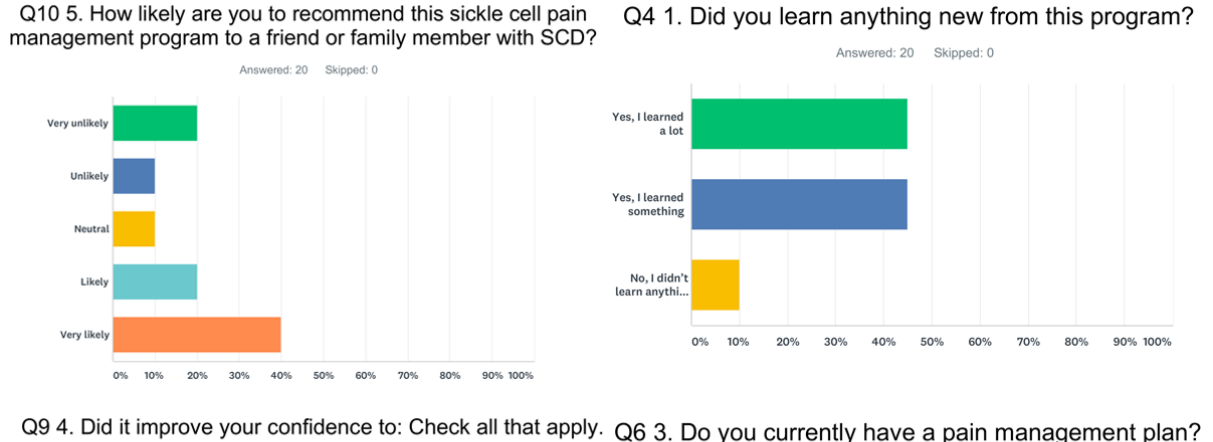
Figure 1. Excerpts from postmodule survey responses. SCD: sickle cell